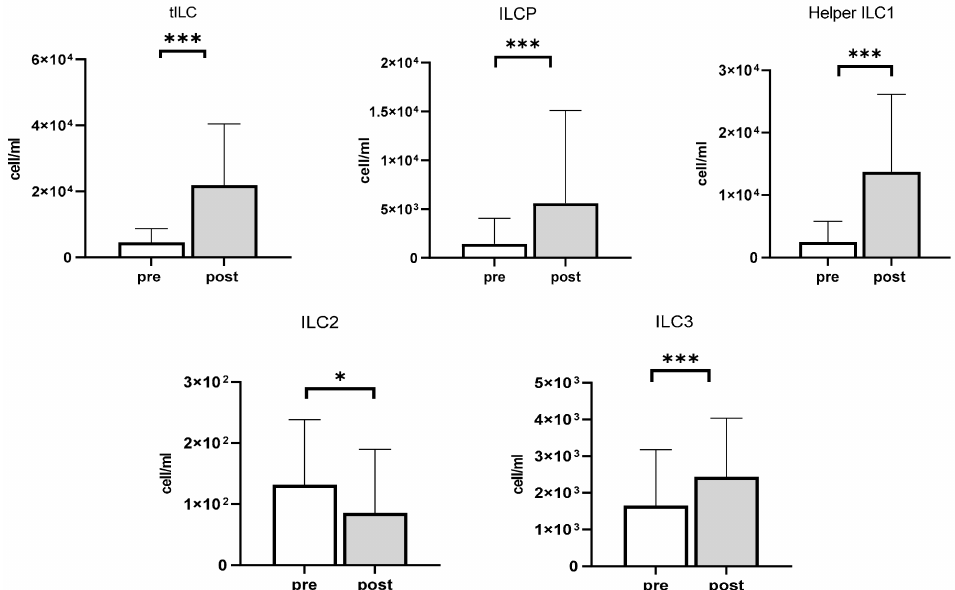
Figure 3. The effects of acute exercise on the mobilization of discrete ILC subsets in healthy young adults ( n = 22). Pre- exercise values are represented in white, whereas post-exercise values are represented in light gray. * Significant differences between pre- and post-exercise p < 0.05, p < 0.01. *** Significant differences between pre- and post-exercise, p < 0.001. Data are mean ±